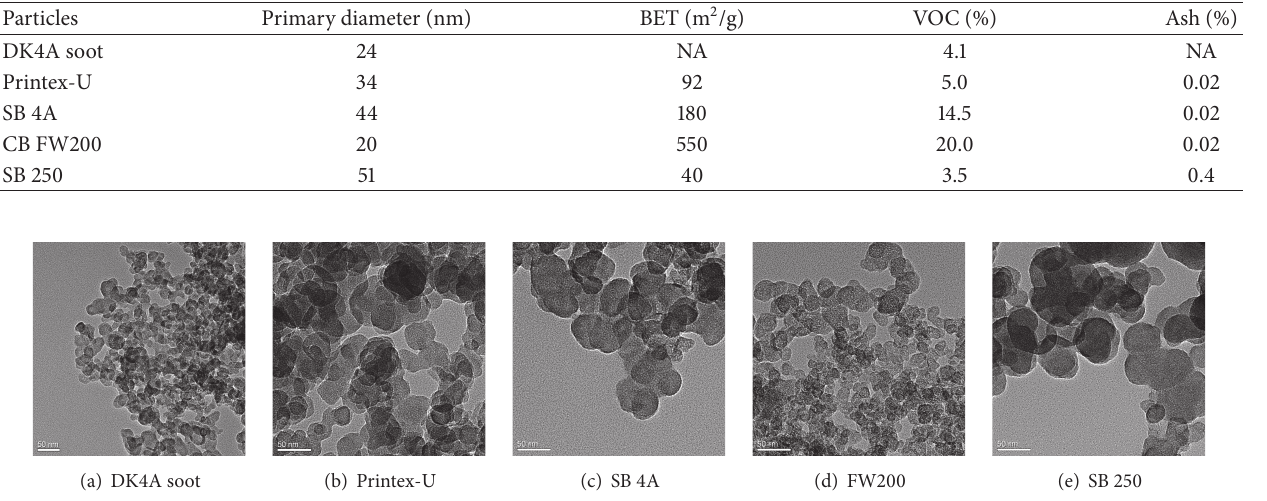
Figure 4: The TEM pictures of different particles.